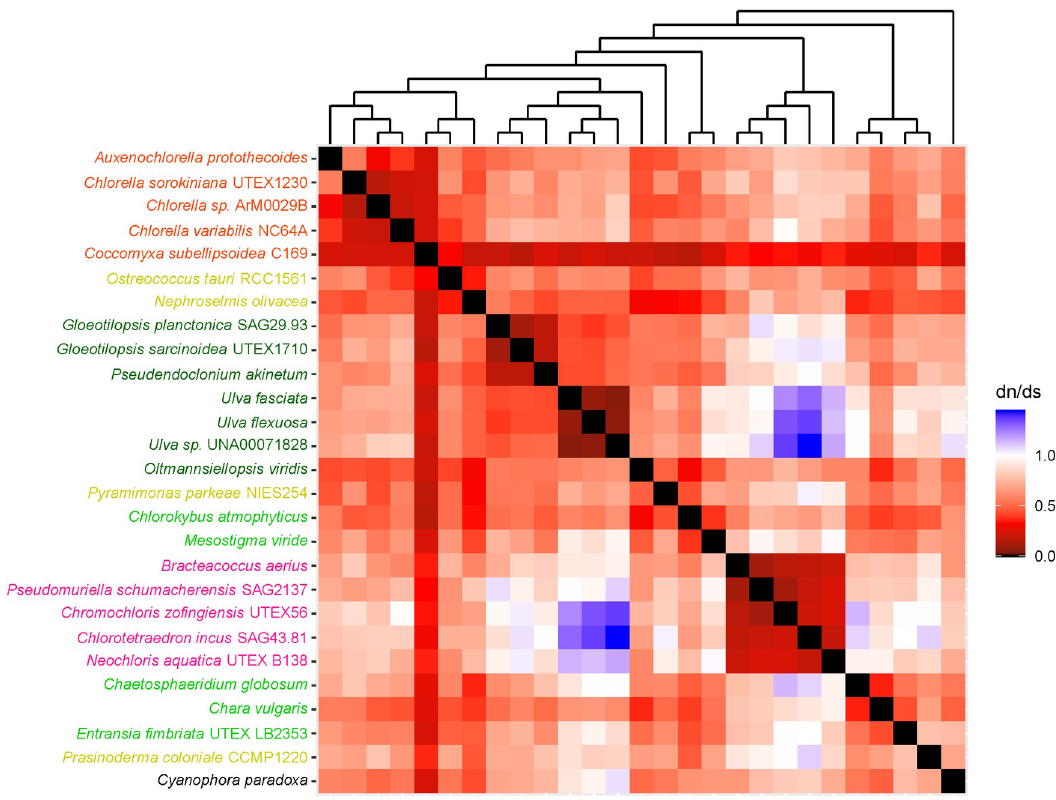
Fig 8. Heatmap of pairwise dN/dSdn/ds ratios calculated from alignment of plastid rps 4. The scale bar represents color corresponding to pairwise dN/dS ratios. The cladogram above the heatmap corresponds to phylogenetic relationship estimated using algal rps